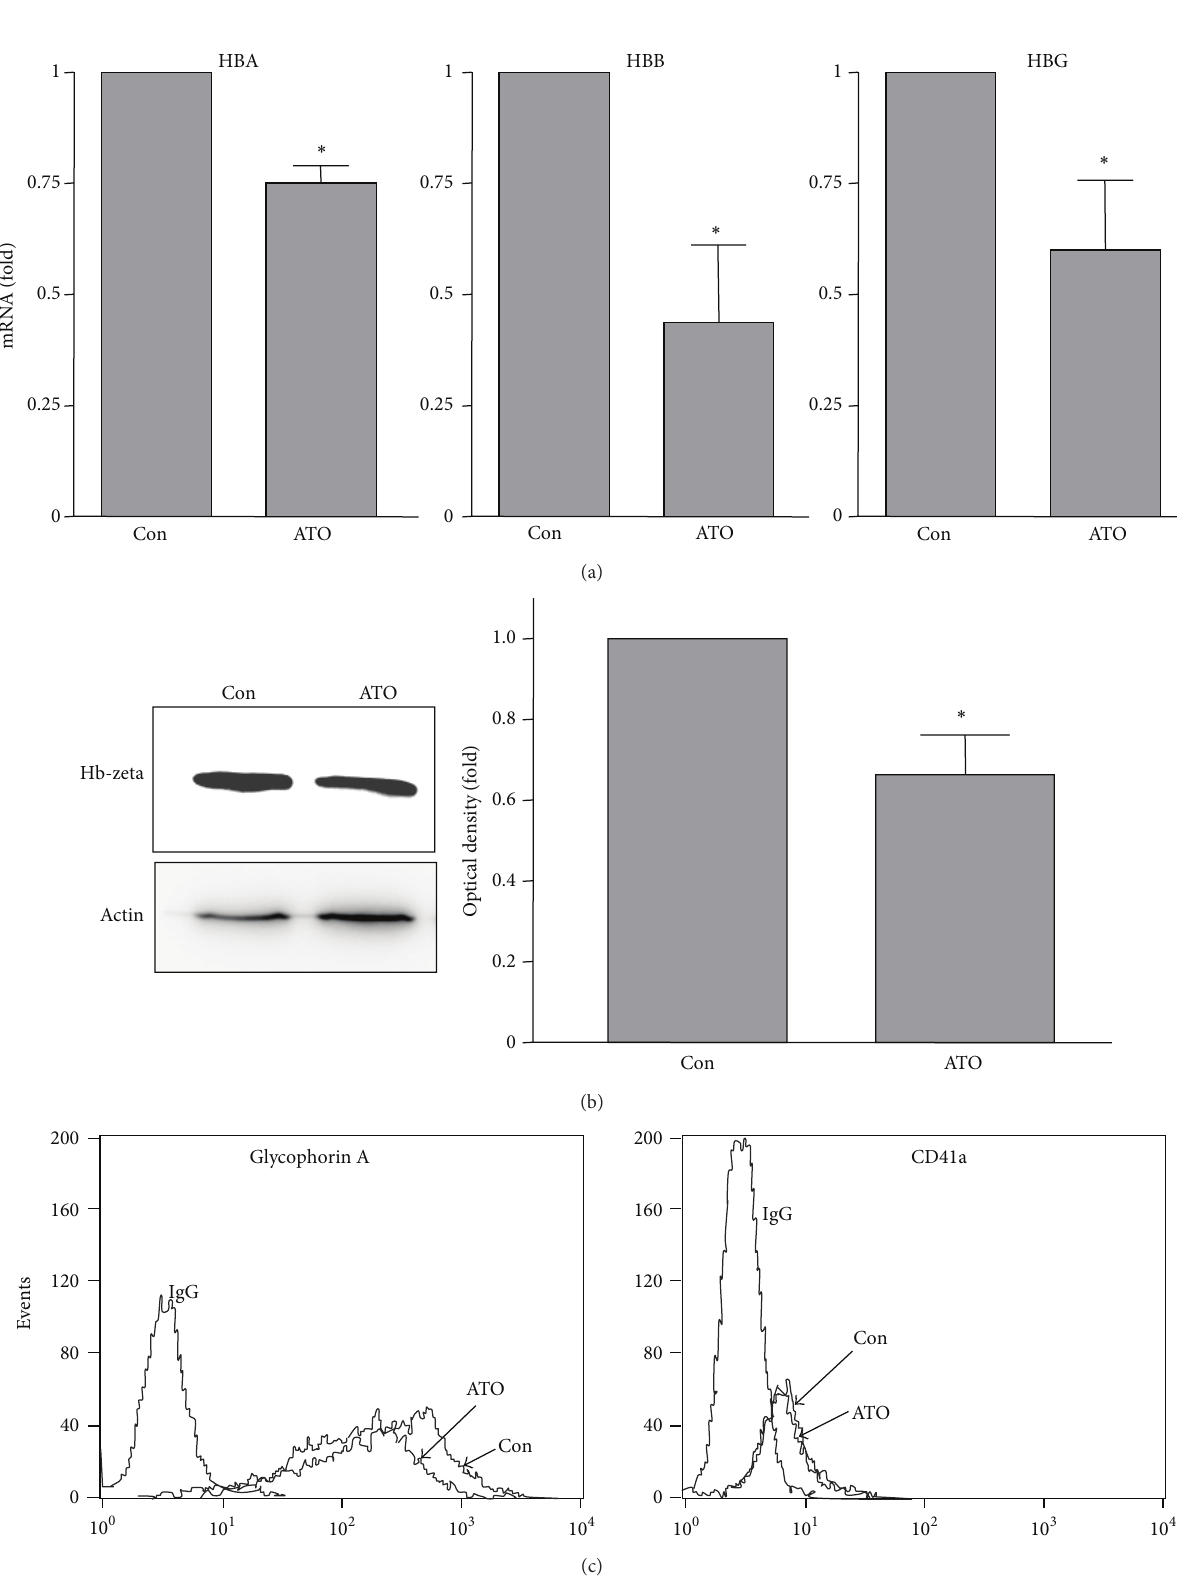
Figure 2: Effects of 0.5 𝜇 M of ATO (treatment for 5 days) on (a) mRNA expression levels of hemoglobin genes (qPCR), (b) protein expression of hemoglobin-zeta (western blotting), and (c) cell surface expression levels of glycophorin A and CD41a (flow cytometry) in K562 cells. Data were mean ± SEM. ∗ 𝑃 < 0.05 versus control, unpaired 𝑡 -test, 𝑛 = 3 - 4